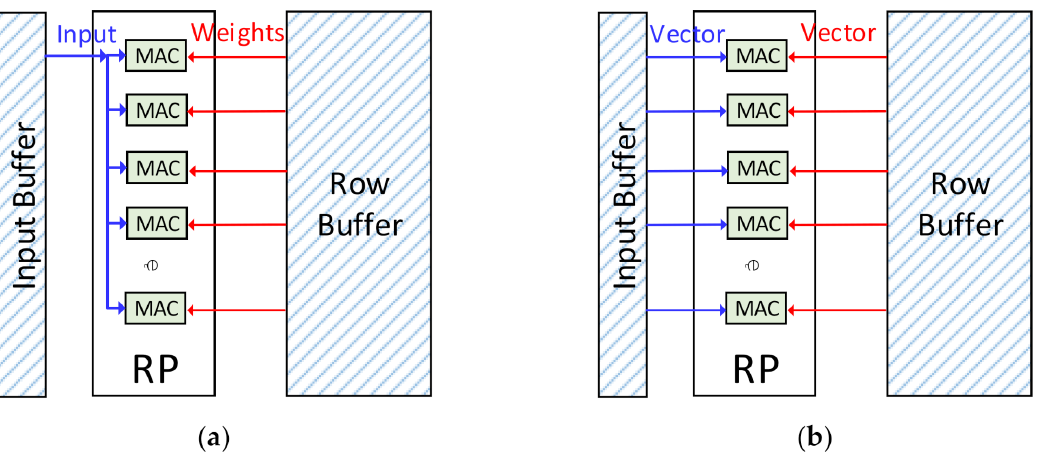
Figure 9. The workflow on the row processor: ( a ) The workflow of the FC layers. ( b ) The workflow of the element-wise